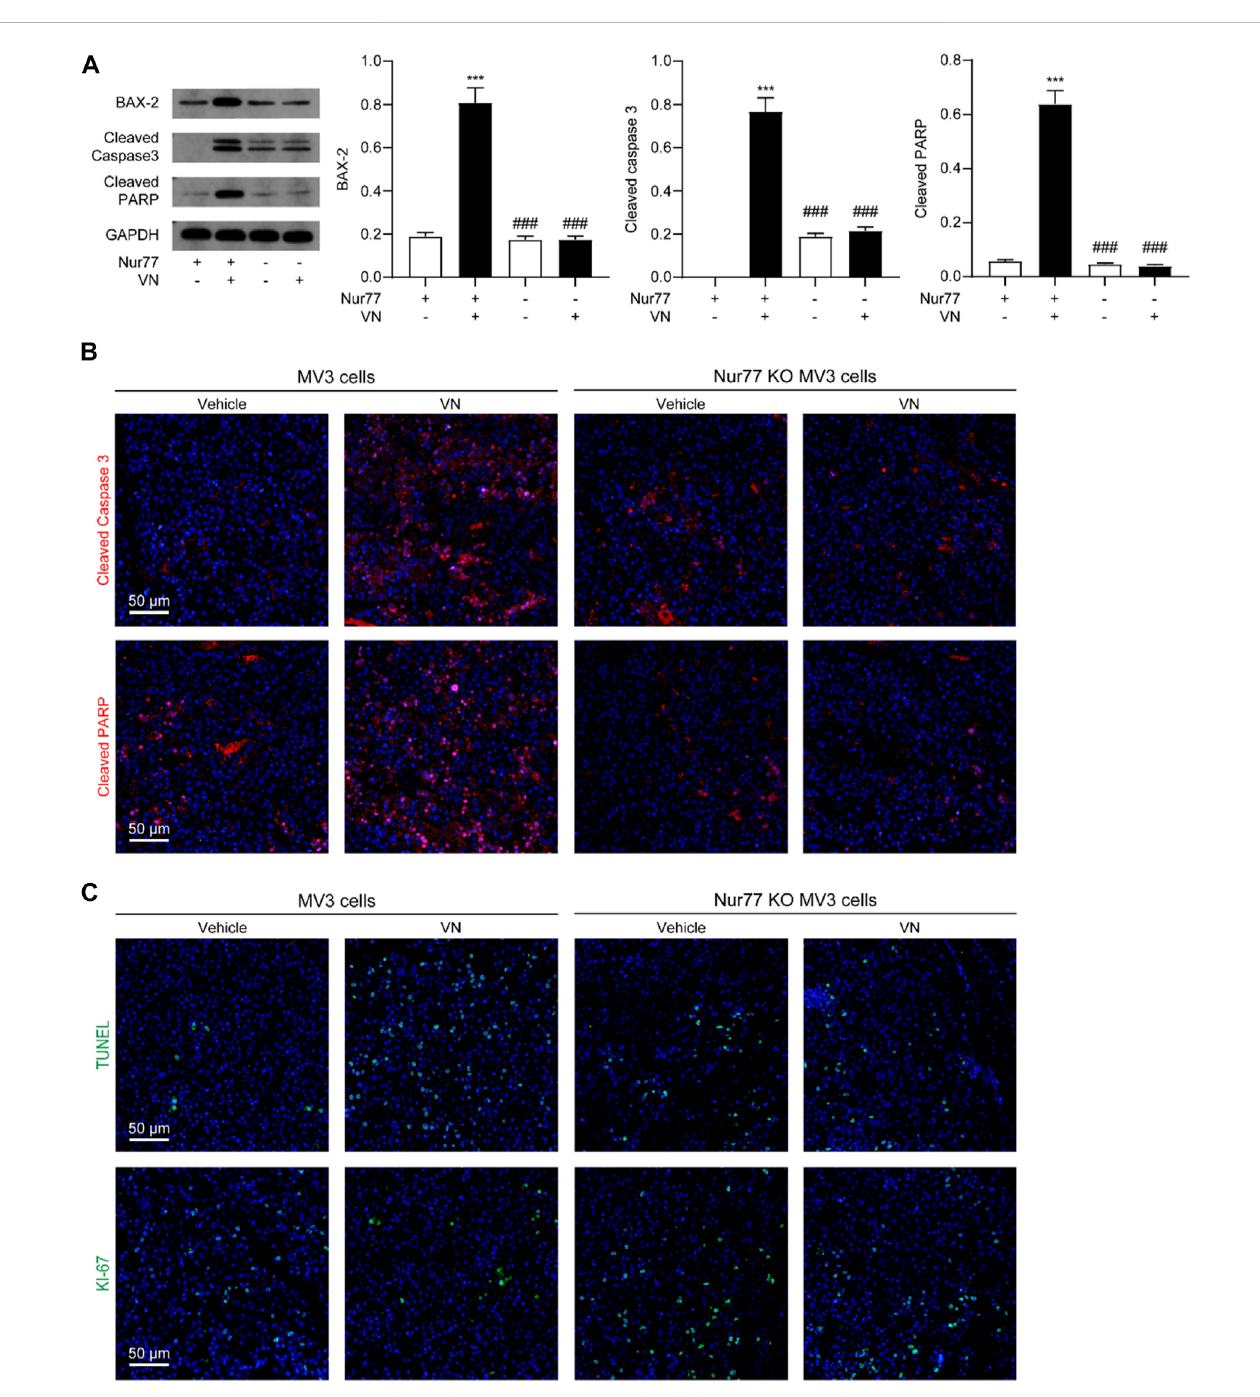
FIGURE 7 Venlafaxine-induced apoptosis invivo .BALB/cnudemicebearingWTMV3orNur77KOMV3xenografttumorsweretreatedwithvenlafaxine(20 mg/kg, i.p.)oritsvehicleoncedailyfromweek1toweek5after implantationofMV3orNur77KOMV3cells. (A) Representativewestern-blotbandsandquanti fi cation of BAX-2, cleaved caspase 3 and cleaved PARP abundances in tumor tissues. N = 5, *, p < .05, **, < .01, ***, p < .001 vs. MV3 vehicle control. ### , p < .001 vs. MV3 venlafaxine control. (B) Tumor tissues were immunostained with cleaved caspase 3 and cleaved PARP antibodies and visualized by confocal microscopy. (C) Tumor tissues were immunostained with TUNEL assay kits and antibodies and Ki-67 visualized by confocal microscopy. One of fi ve similar experiments is